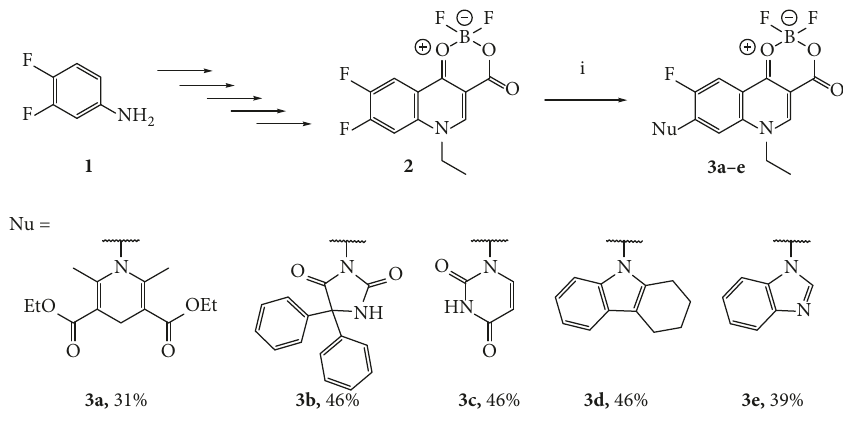
Figure 1: Synthesis of hybrid fluoroquinolone-boron complex 3a–e.